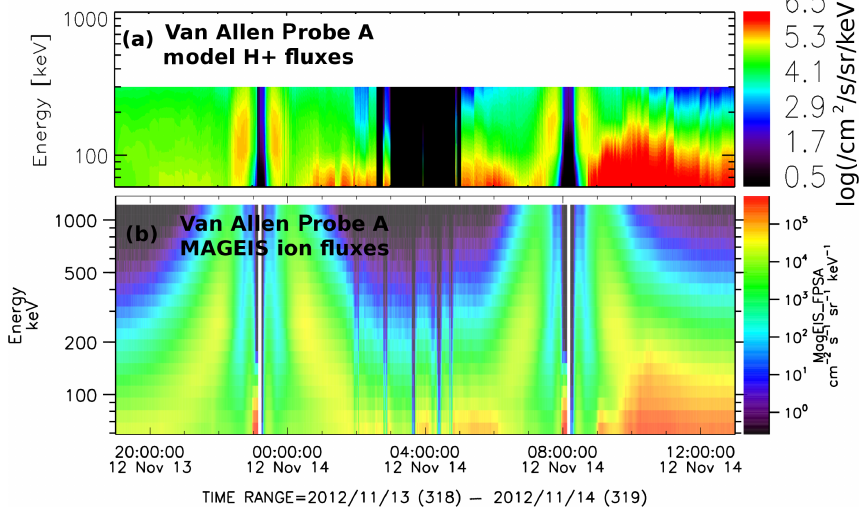
Figure 7. Modeled ion fluxes (a) along Probe A trajectory together with MAGEIS ion fluxes (b) . The color scale is logarithmic. The units are cm − 2 /s/sr/keV for both panels. The black area between ∼ 03:00 and 05:00UT in the modeled spectrogram denotes the modeled